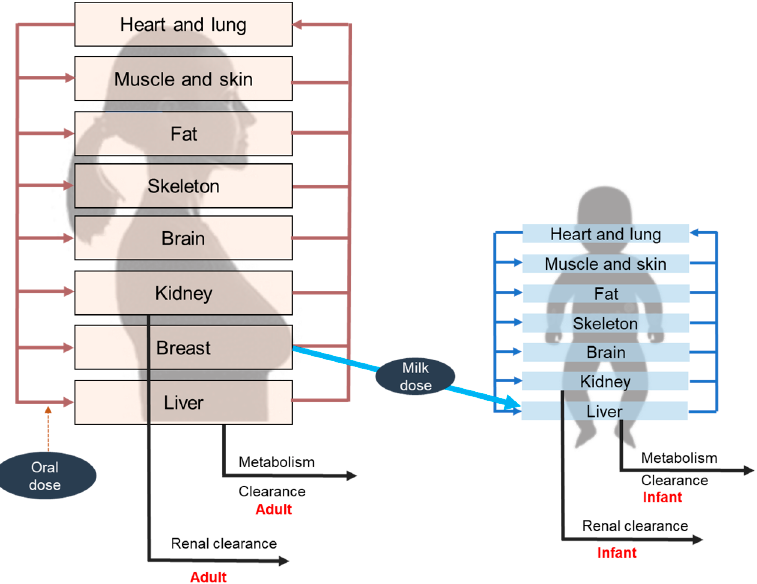
Figure 2. Conceptual representation of physiologically based pharmacokinetic (PBPK) model for the lactating mother and the breastfed infant.